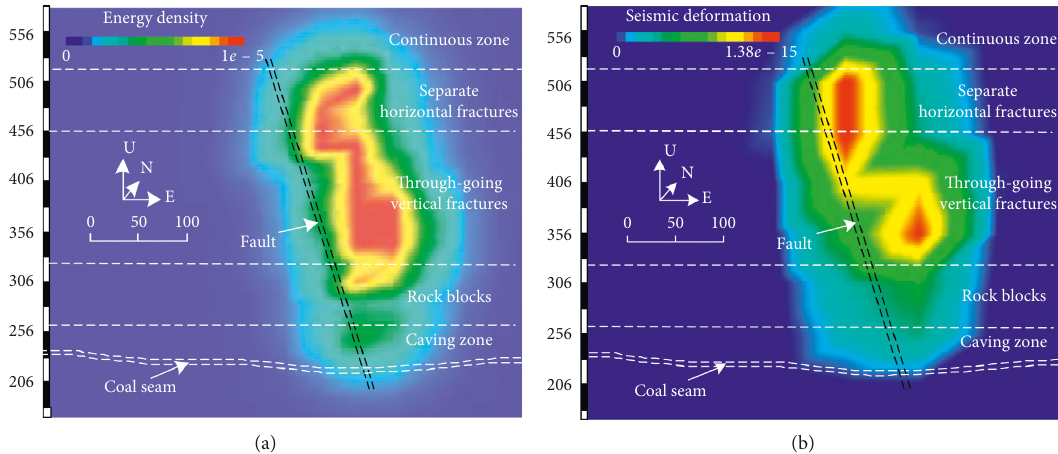
Figure 4: Spatial distribution of major parameters of microseismic events between Nov 12, 2015, and Dec 15, 2015. (a) Energy density and (b) seismic